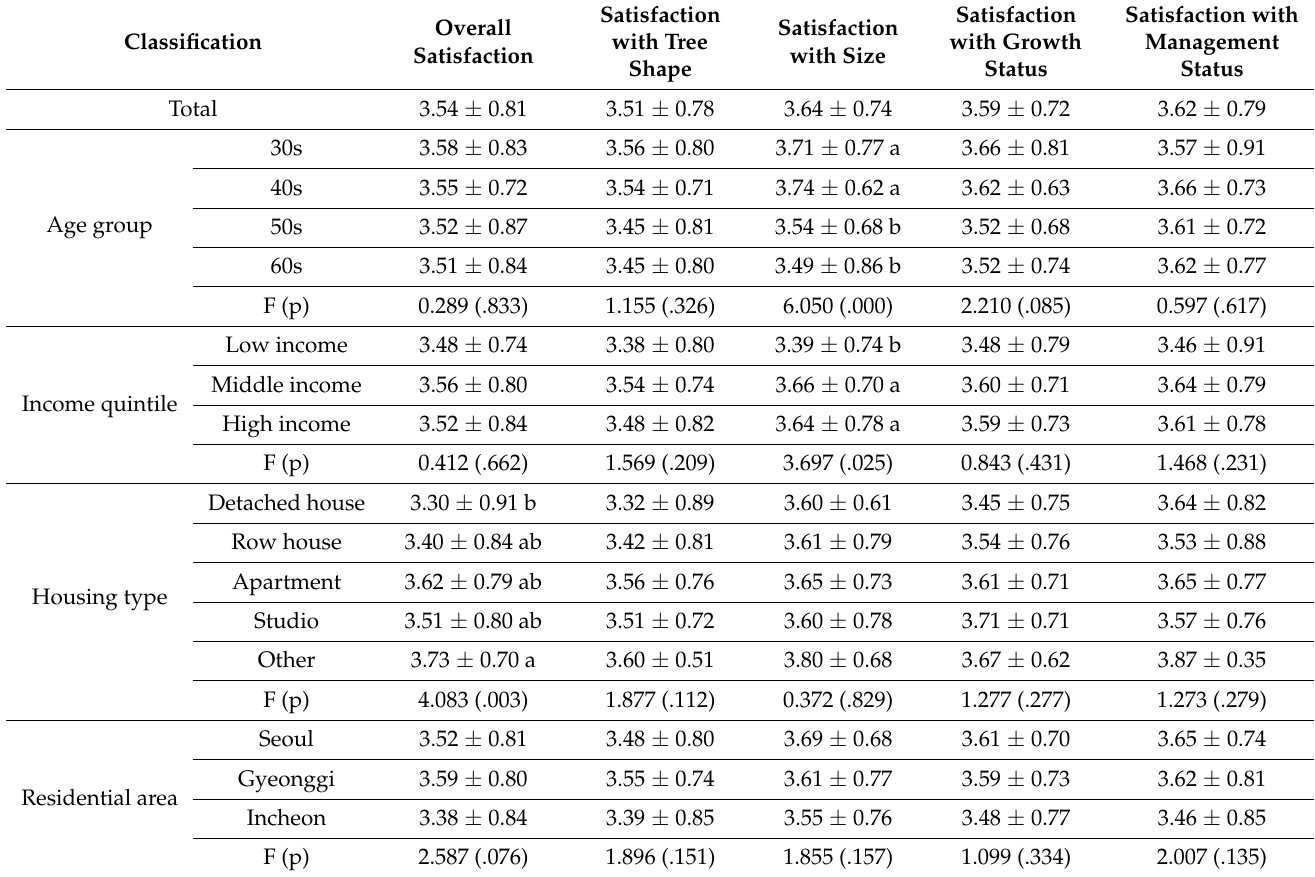
Table 6. Demographic characteristics of satisfaction with street